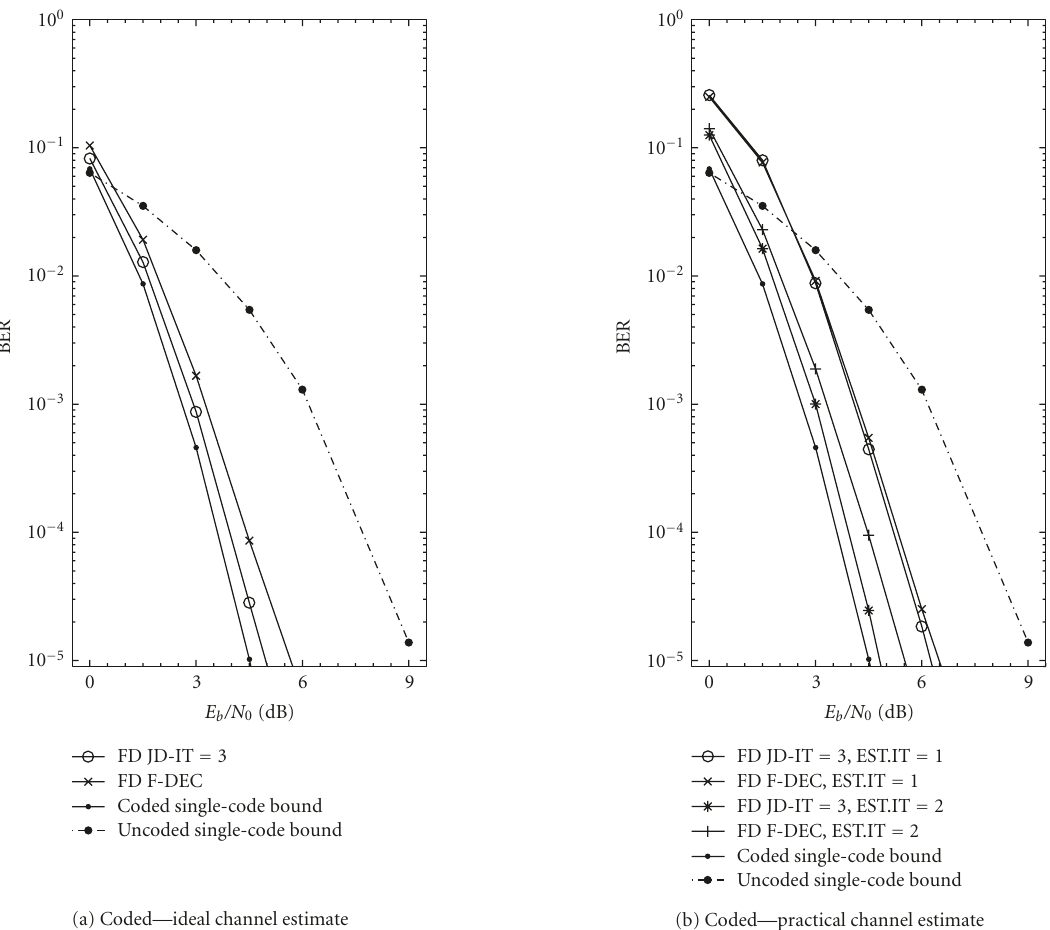
Figure 7: Average BER with one full-rate user and with channel coding in